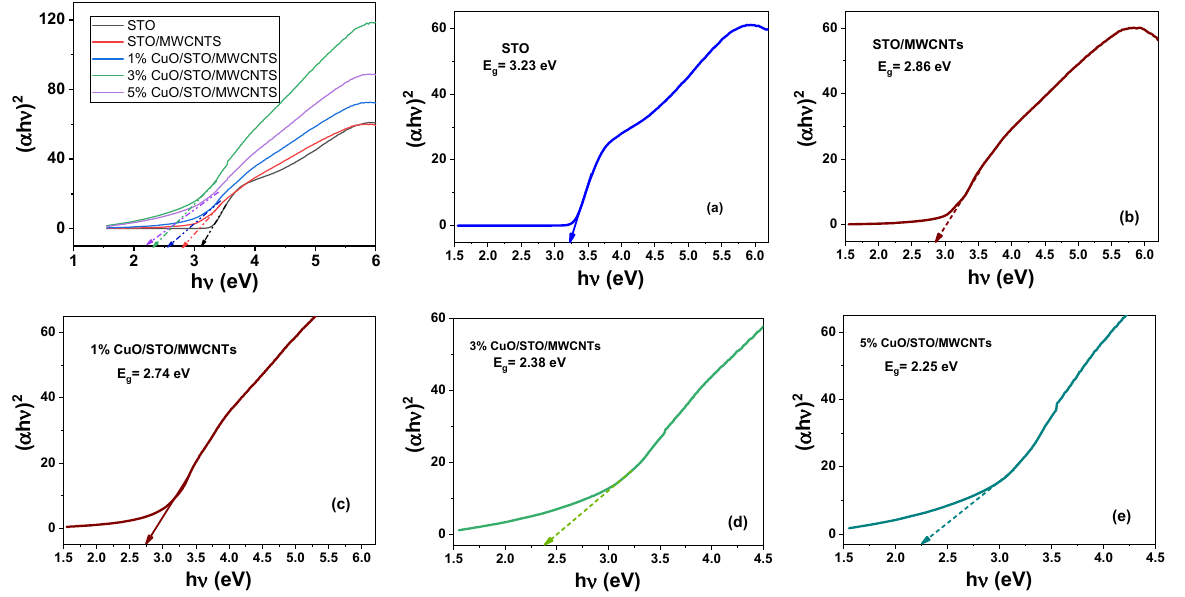
Figure 8. The band gap energy of STO ( a ), STO/MWCNTs ( b ), 1% CuO/STO/MWCNTs ( c ), 3% CuO/STO/MWCNTs ( d ), 5% CuO/STO/MWCNTs ( e ). 2.2. Photocatalytic Activity of the x% CuO/STO/MWCNTs To investigate the adsorption performance of the materials, the beaker was placed in the dark with constant magnetic stirring. As shown in Figure 9a, after 30 min, the adsorp- tion/desorption equilibrium was reached. The adsorption percentages (H%) were about 10% under dark adsorption (Figure 9b).